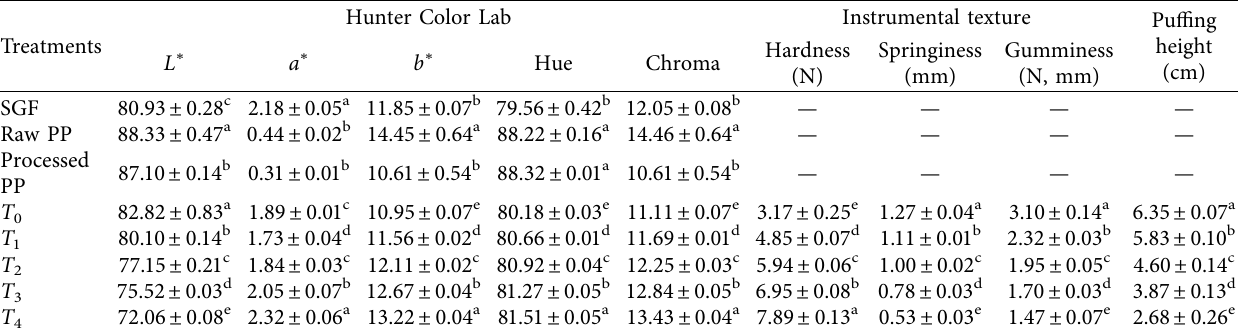
Values are means ± S.D. ( n � 2). Values having identical lettering in each column are nonsignificant at p > 0 . 05. T 0 � 100% straight-grade wheat flour chapatis (control),